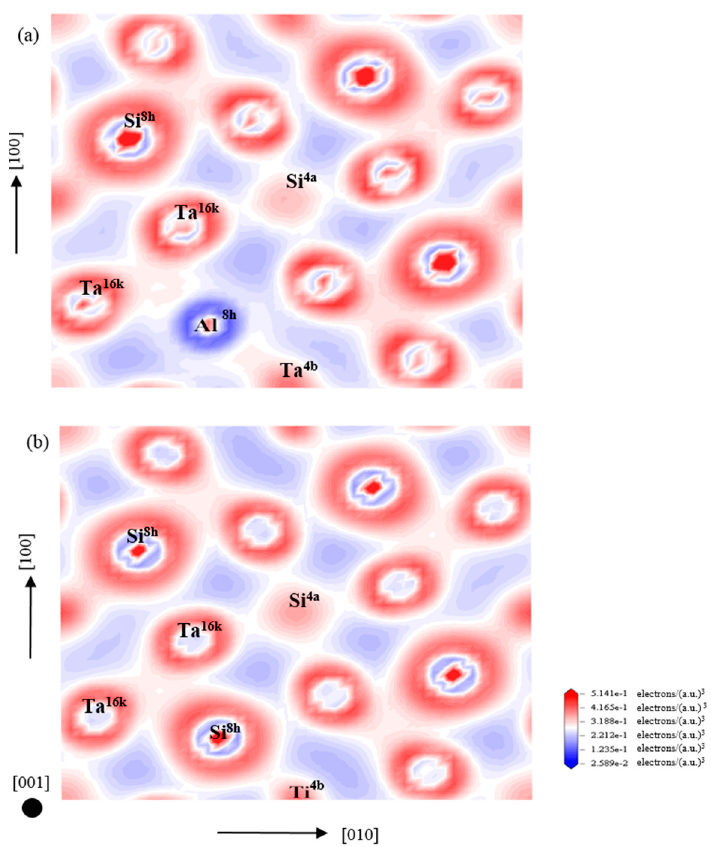
Figure 9. The difference density of contour plots for ( a ) Ta 20 Si 11 Al 8h and ( b ) Ta 19 Ti 4b Si 12 unit cell in (001) plane. ● denotes the direction perpendicular paper from inside to outside. The Ta 4b , Ta 16k , Si 4a , Si 8h , Al 8h and Ti 4b symbols designate the positions of, respectively, Ta in the 4b site, Ta in the 16k site, Si in